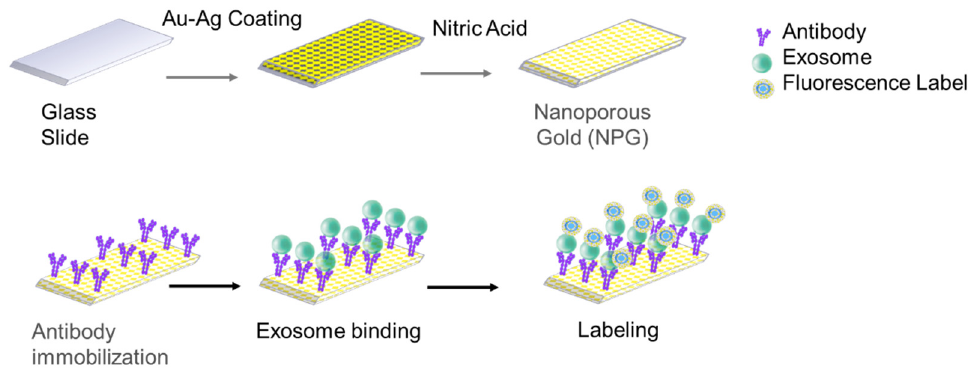
Figure 2. Schematic overview of the integration of exosomes with NPG. A nanoporous gold substrate (NPG) was fabricated on a glass slide using a sputtering machine. Exosomes were recognized and immobilized on the nanoporous gold substrate (NPG) via the target-specific antibodies anchored on the surface of the substrate.